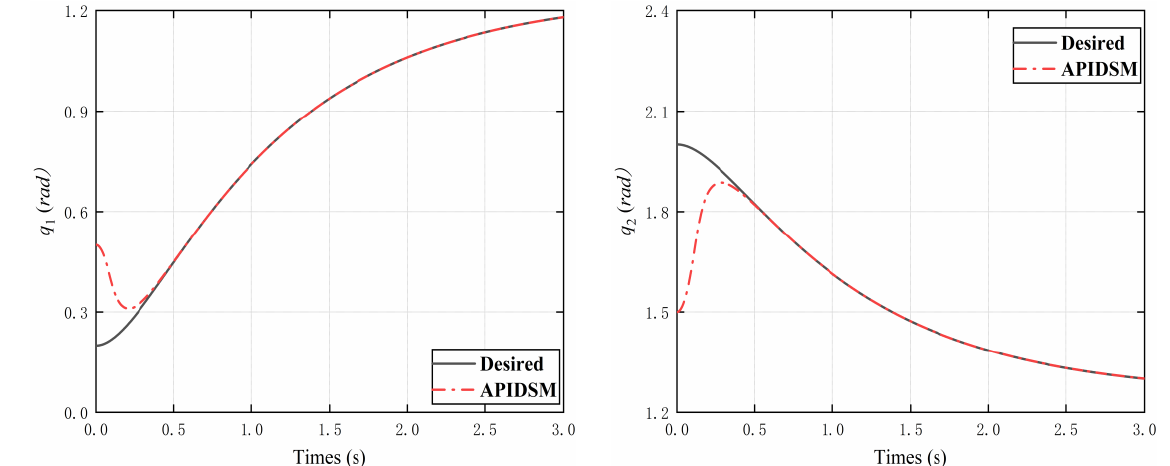
Figure 4. Position tracking results of Joint 1 and Joint 2.